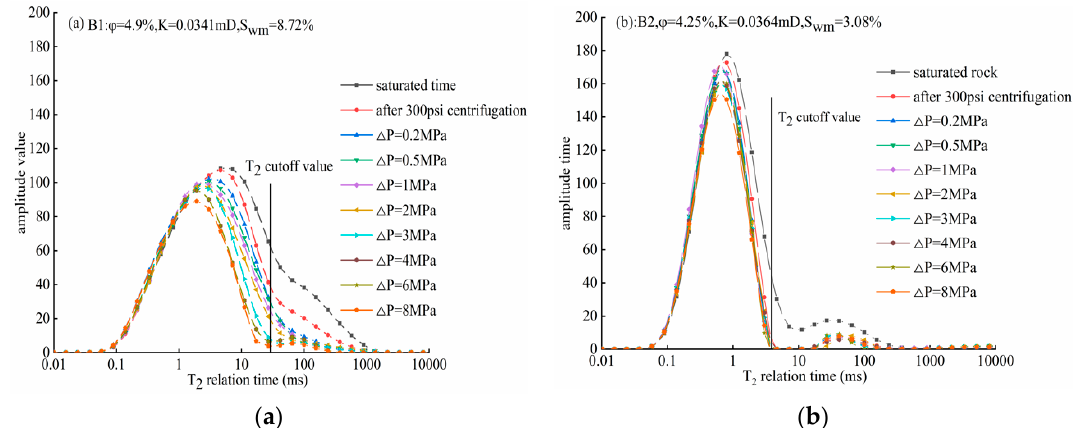
Figure 3. T 2 spectrum curve of tight sandstone cores B1 ( a ) and B2 ( b ) in different differential pressures.